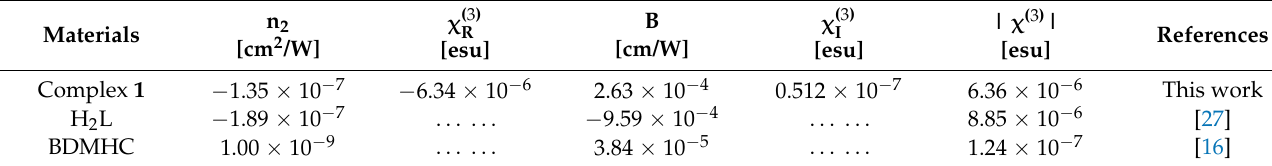
Table 3. Third-order NLO characteristics of complex 1 and its ligand (H 2 L) and comparison with other reported materials.